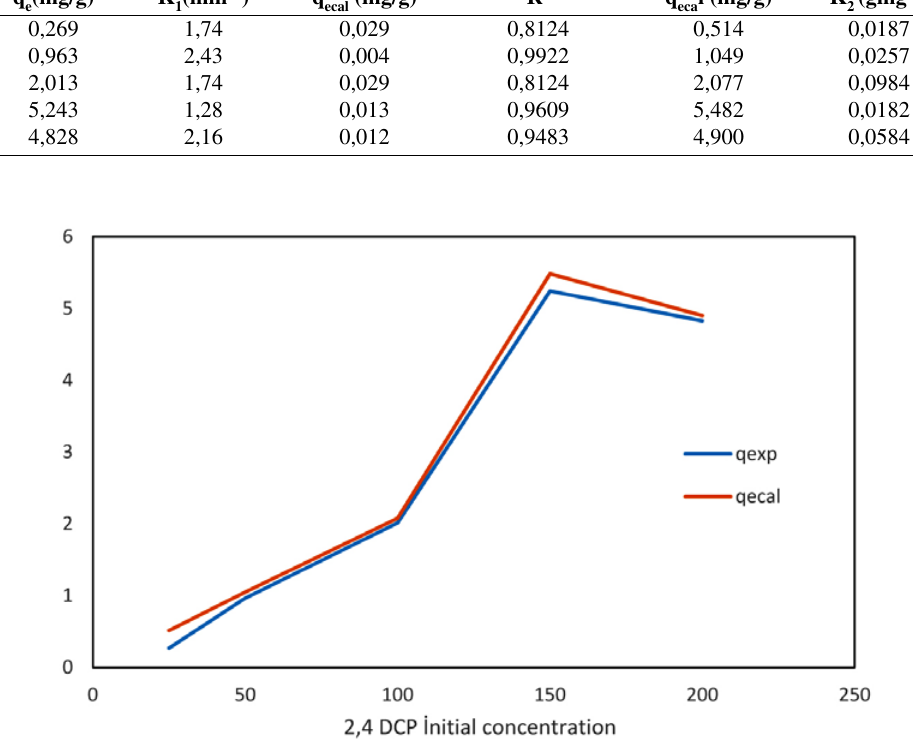
Table 3 . Parameters of Lagergren-first order kinetic model Pseudo-second order kinetic model for 2,4- DCP adsorption onto sweetgum bark (pH: 2; biomass: 1 g, temperature 20 ± 0.5, agitation rate: 125 rpm) (mg/L) Lagergren-first order kinetic model Pseudo-second order kinetic model